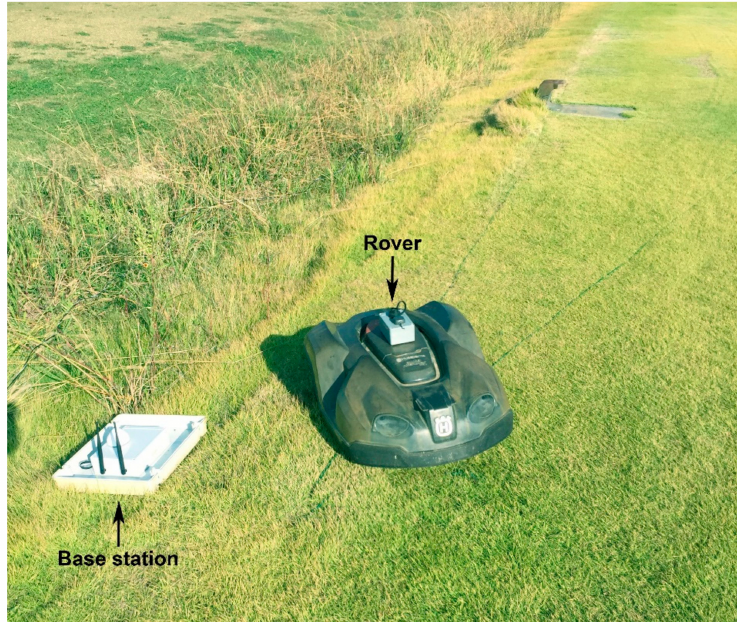
Figure 1. Custom-built cases containing the two Reach real-time kinematic (RTK) devices, one functioning as a base station and the other as the rover. The rover was mounted on the robot mower, and the base station was positioned at the edge of the turfgrass.